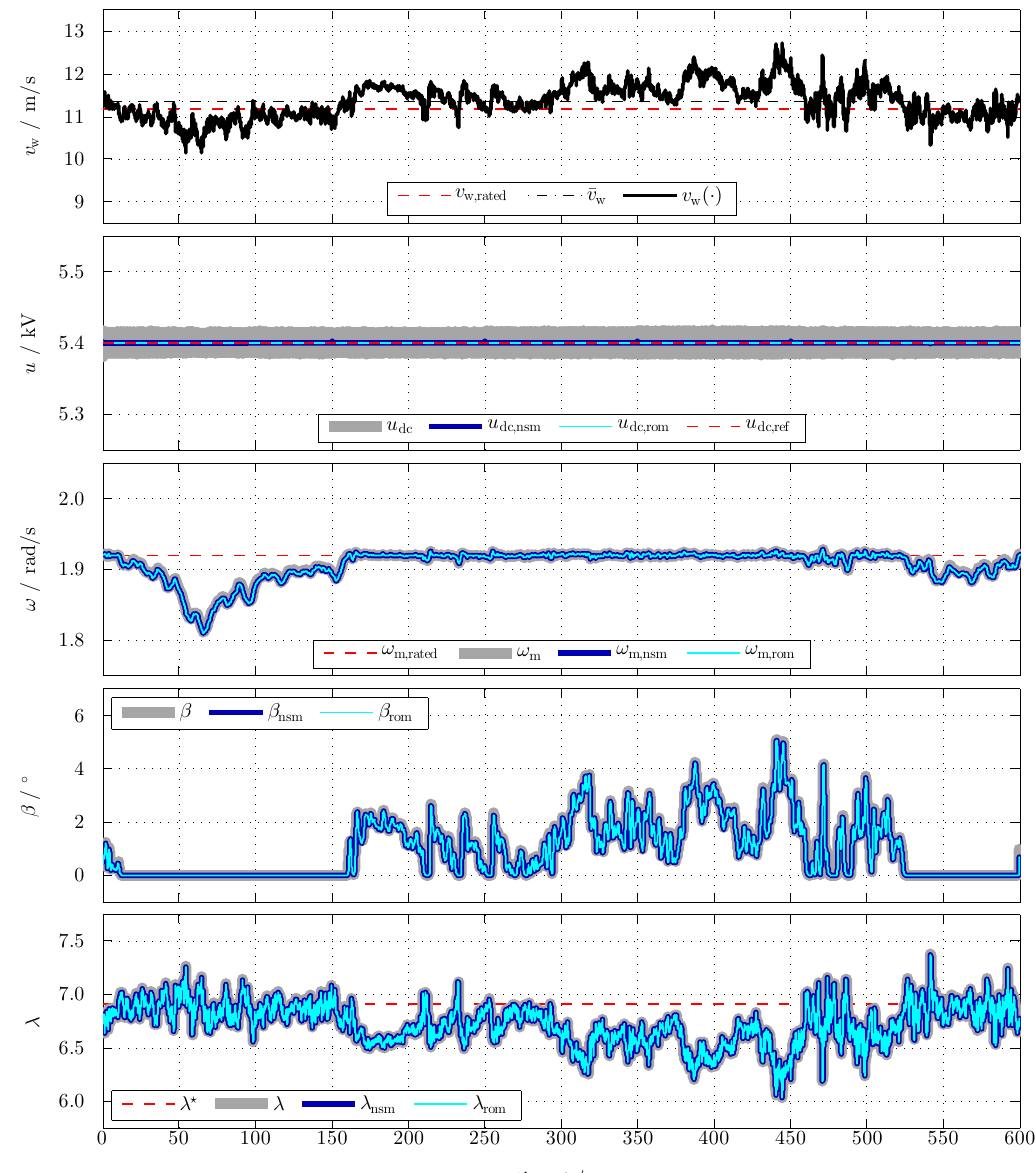
Figure 10. Comparison of DC-link voltages, mechanical angular velocities, and pitch angles. The upper subplot in Figure 10 shows the wind speed v w , its mean value ¯ v w and the nominal wind speed v w,rated of the WTS. In the major part of the simulation (mainly around t = 150, . . . , 530 s), the wind speed is significantly higher than the nominal wind speed of the turbine. Thus, the WTS models are operated in both considered regimes: regime II and regime III. The averaged wind speed is slightly above the nominal wind speed. In the second subplot, the DC-link voltages are depicted: u dc,nsm (of non-switching model) and u dc,rom (of reduced-order model) coincide and track their reference value of 5.4 kV nicely. The voltage u dc (of the full-order model) also tracks its reference value but due to the modeled switching behavior of the power converters it is not as smooth as the